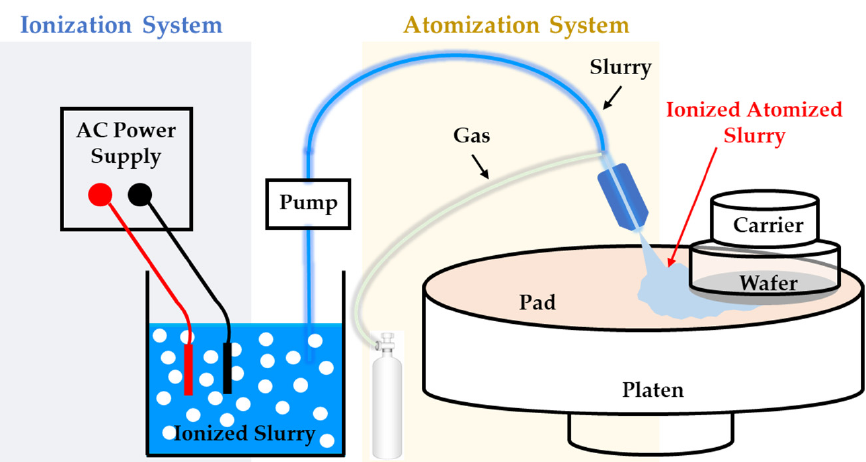
Figure 2. Schematic of the proposed hybrid slurry supply system combining the ionization and atomization systems.